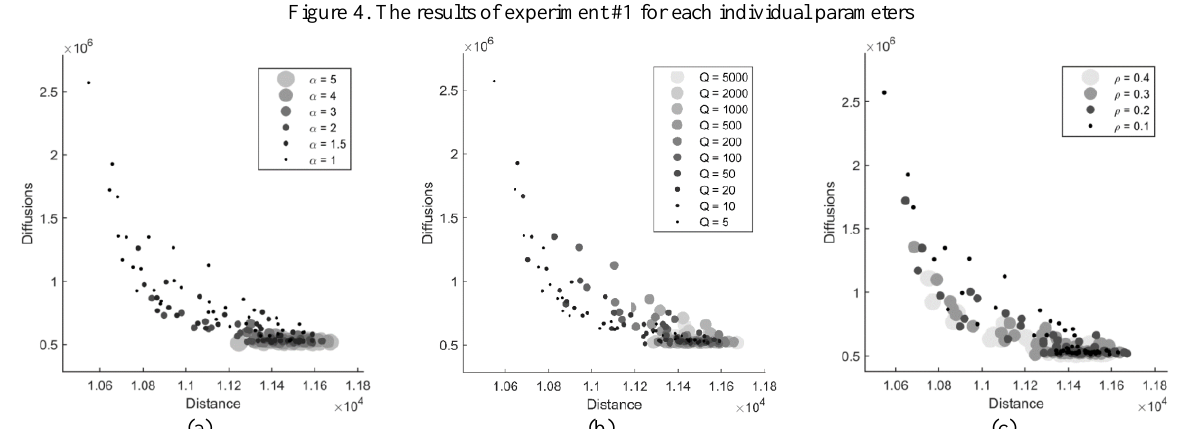
Figure 5. The Diffusion-Distance plot of results for (a) Transition rule parameter α, (b) Evaporation parameter ρ, c) reinforcement parameter